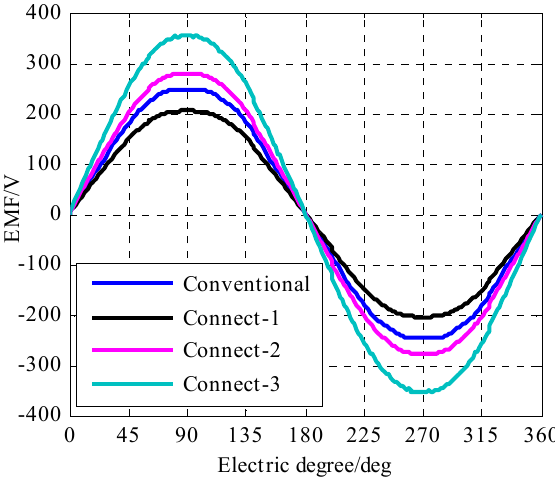
Figure 12. Back electromotive force (EMF) waveforms.